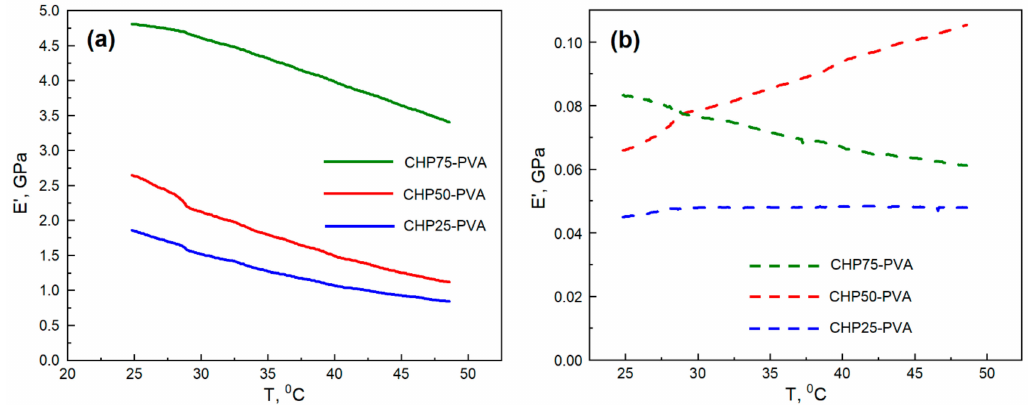
Figure 9. Relationship between the storage modulus and temperature of the base-neutralized films in their ( a ) dry, and ( b ) wet